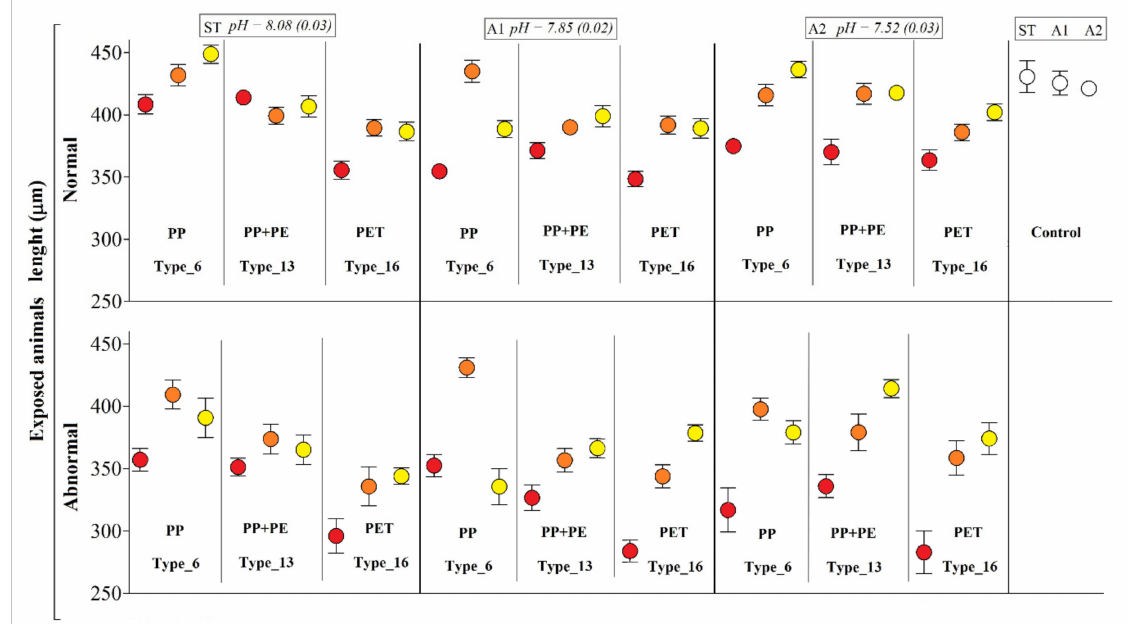
Figure 4. Body-size of P. lividus larvae exposed to different plastic types according to water pH and leachate dilutions. Results are expressed as mean arms lengths ( ± SD) and calculated in both normal and abnormal larvae. Negative controls on the right. Tests were performed under three different pH scenarios: ST = standard marine water, pH 8.1; A1 = acidified ( − 0.3 pH units), pH 7.80; A2 = extremely acidified ( − 0.6 pH units), pH 7.50. Three different dilutions of the initial packaging leachate were used (red dots = 100%; orange dots = 50%; yellow dots = 25%) for PP (Type_6), PP + PE (Type_13), and PET (Type_16). Data present the Abbott’s